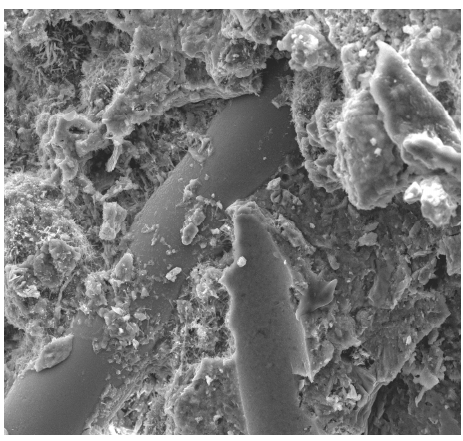
Figure 10. Single POF bundle structure in a cement matrix and elemental analysis results in the EDS micromatrix of a cement matrix at 100X magnification.